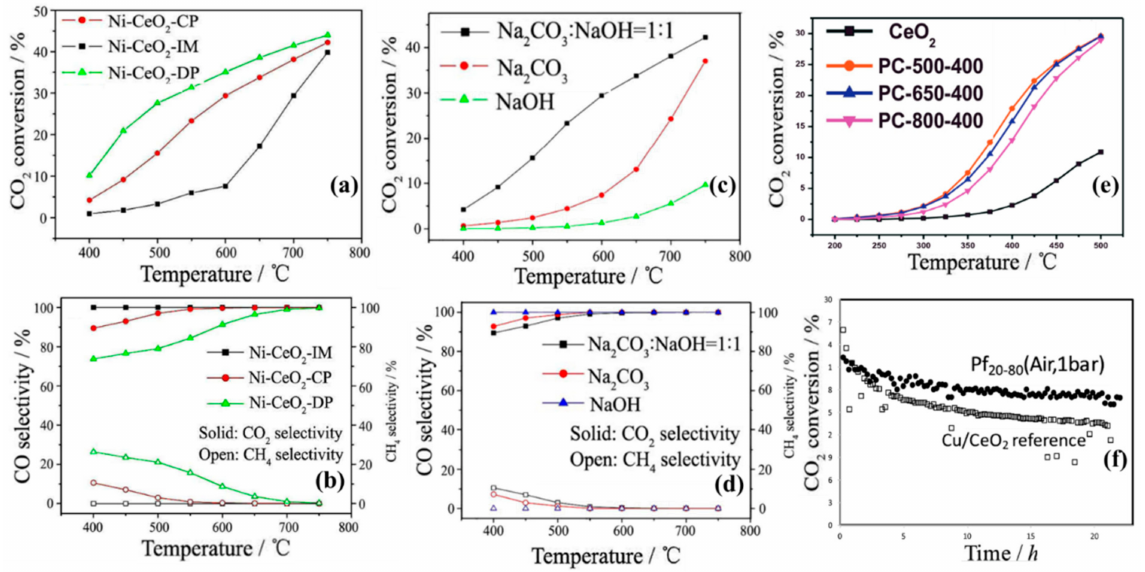
Figure 9. Effect of preparation methods on metal-CeO 2 RWGS reaction: ( a ) Ni-CeO 2 -activity, reprinted with permission from [121]. Copyright Elsevier, 2013, ( b ) Ni-CeO 2 -selectivity, reprinted with permission from [121]. Copyright Elsevier, 2013, ( c ) Ni-CeO 2 -activity, reprinted with permission from [130]. Copyright Elsevier, 2013, ( d ) Ni-CeO 2 -selectivity, reprinted with permission from [130]. Copyright Elsevier, 2013, ( e ) Pt-CeO 2 , reprinted with permission from [94]. Copyright Elsevier,